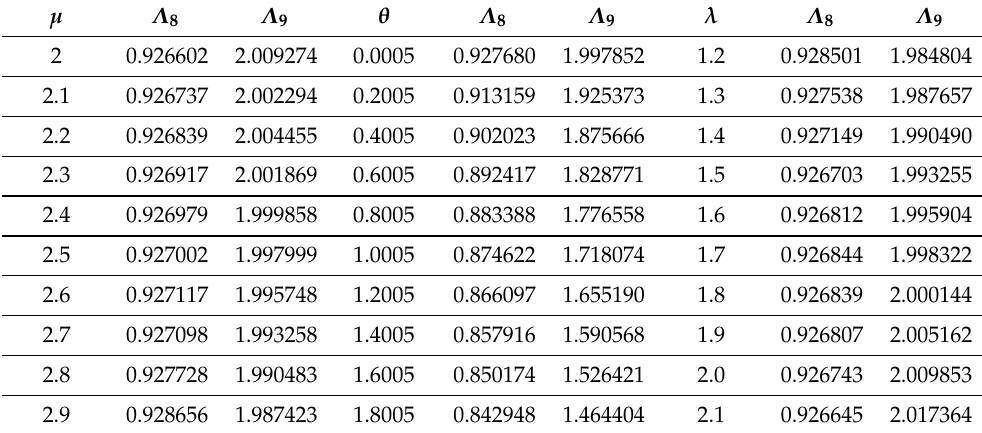
Table 10. Influence of λ , µ and θ on the fraction of successful rate of retrials and mean number of active servers for c =